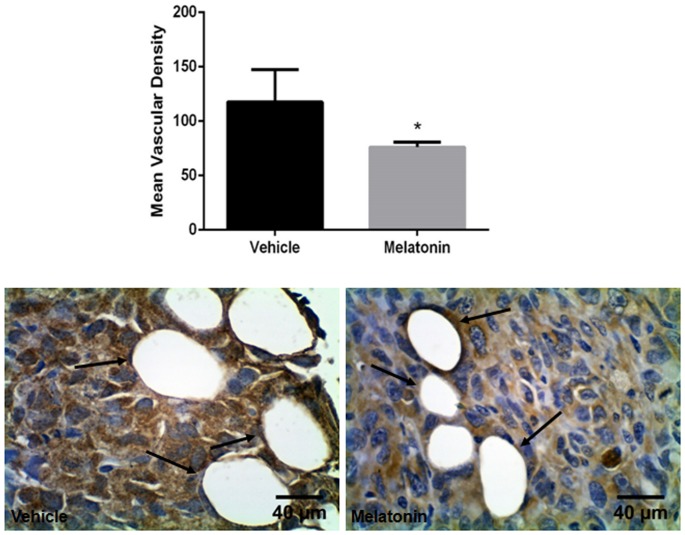
Immunohistochemistry staining with vWF in vehicle treated and melatonin treated tumors.Images were taken with 40× magnification. Quantitative estimation of micro-vessel density (MVD) by counting positive vessels (arrows) revealed a decrease in MVD after melatonin treatment compared to the vehicle treated tumor (*p<0.05). Error bars: ± standard error.